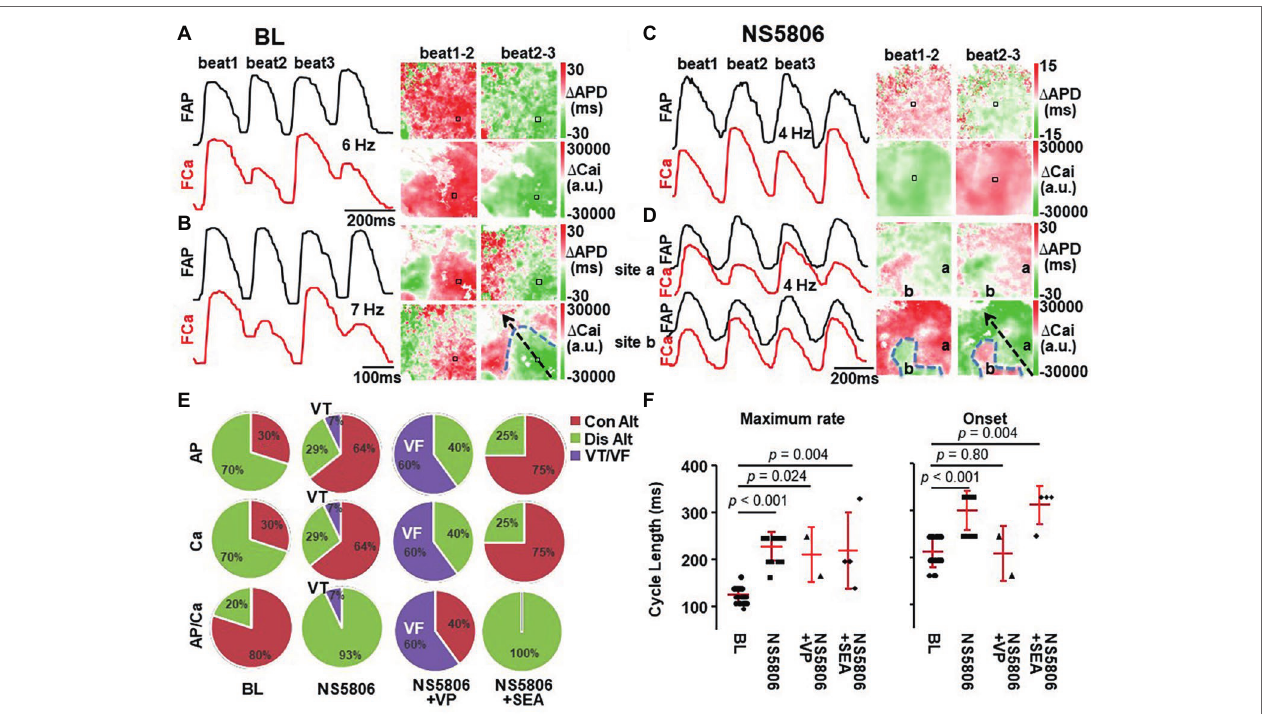
FIGURE 5 | Alternans dynamics. At BL, pacing-induced alternans was predominantly electro-mechanically (AP/Ca) and spatially concordant (A) . Faster pacing made alternans spatially discordant with a nodal line (blue dotted line) perpendicular to propagation (black arrow) (B) . After NS5806 infusion, alternans was AP/Ca discordant from its onset (C) . Faster pacing made alternans spatially discordant with a nodal line not following propagation direction (D) . (E) The occurrence of alternans and its spatial and AP/Ca concordance at maximum capturing pacing rate. Con Alt, concordant alternans; Dis Alt, discordant alternans. (F) The cycle length of alternans at onset and maximum capturing pacing rate in different conditions. Lines show mean ± SD. p < 0.05 was considered statistically significant.